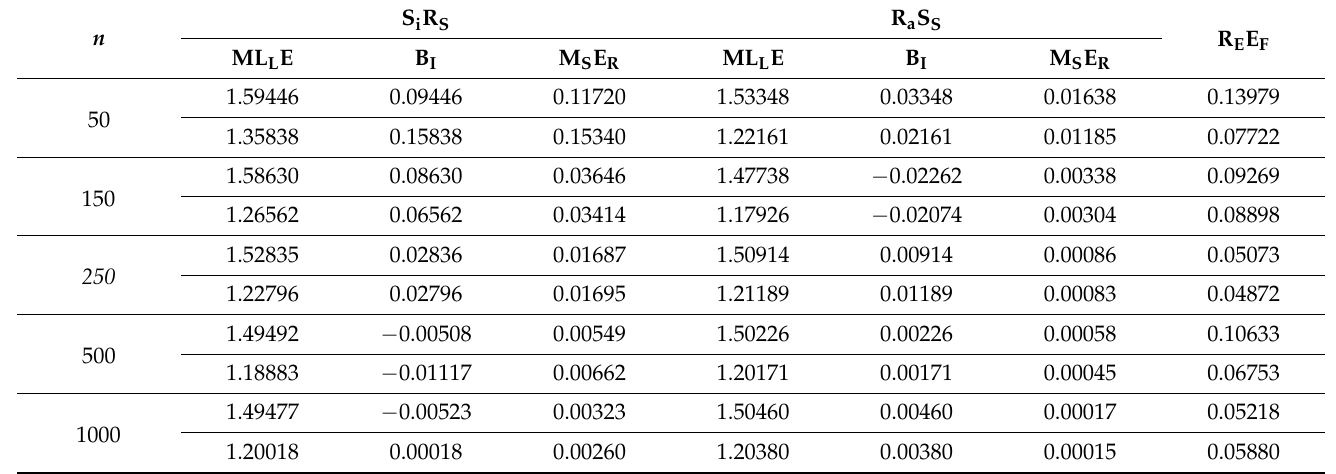
Table 5. The ML L E s , B I s, M S E R , and R E E F of the KMB X model under S i R S and R a S S at α = 1.5, β =